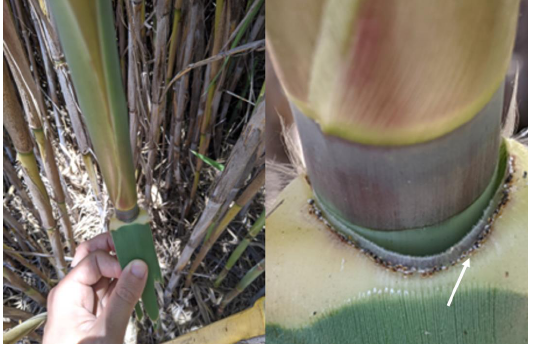
Figure 1. Rhizaspidiotis donacis attached along the leaf sheath of a mature Arundo donax stem. Scales (mainly immature males) can be found along the stem on leaf collars (indicated with arrow) up to one meter from the ground in the spring and summer. Both immature and mature females attach to the rhizome throughout the year. 2.2. Rhizaspidiotis Donacis Genetics Adult R. donacis specimens were collected in Europe between 2007 and 2010 as part